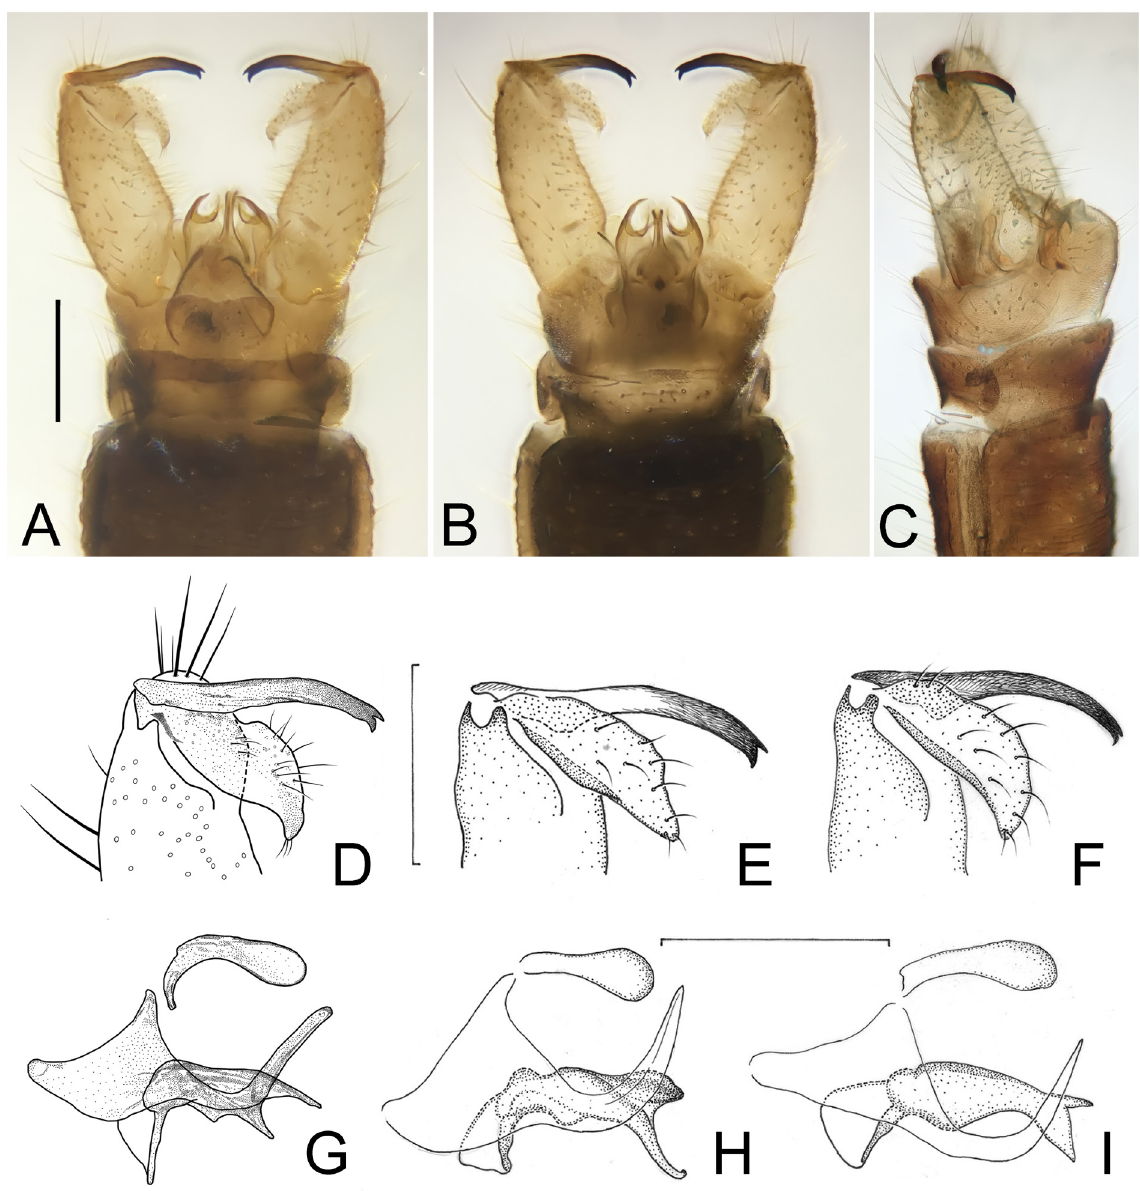
Fig. 4. A–C . Male terminalia of Dicranophragma (B.) relictum Mederos sp. nov. A . Dorsal view. B . Ventral view. C . Lateral view. D–I . Detail of inner and outer gonostylus (dorsal view) and aedeagal complex (lateral view). D, G . D. (B.) relictum Mederos sp. nov. E, H . D. (B.) nemorale (Meigen, 1818). F, I . D. (B.) adjunctum (Walker, 1848). Scale bars = 0.25 mm (images E–F, H–I after Starý & Reusch